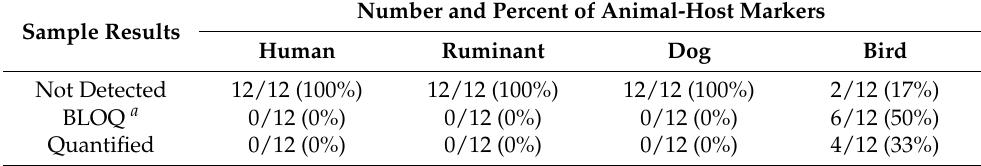
Table 2. Summary of animal–host microbial source tracking marker concentration measurements in samples collected at Clam Beach near Mad River (site 1).